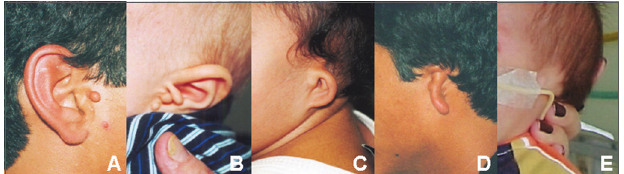
Figure 1. Images showing different grades of microtia in patients of the study sample: normal ear with preauricular appendage (A); grade I microtia with preauricular appendages (B); grade II microtia (C); grade Iii microtia (D), grade IV microtia or anotia